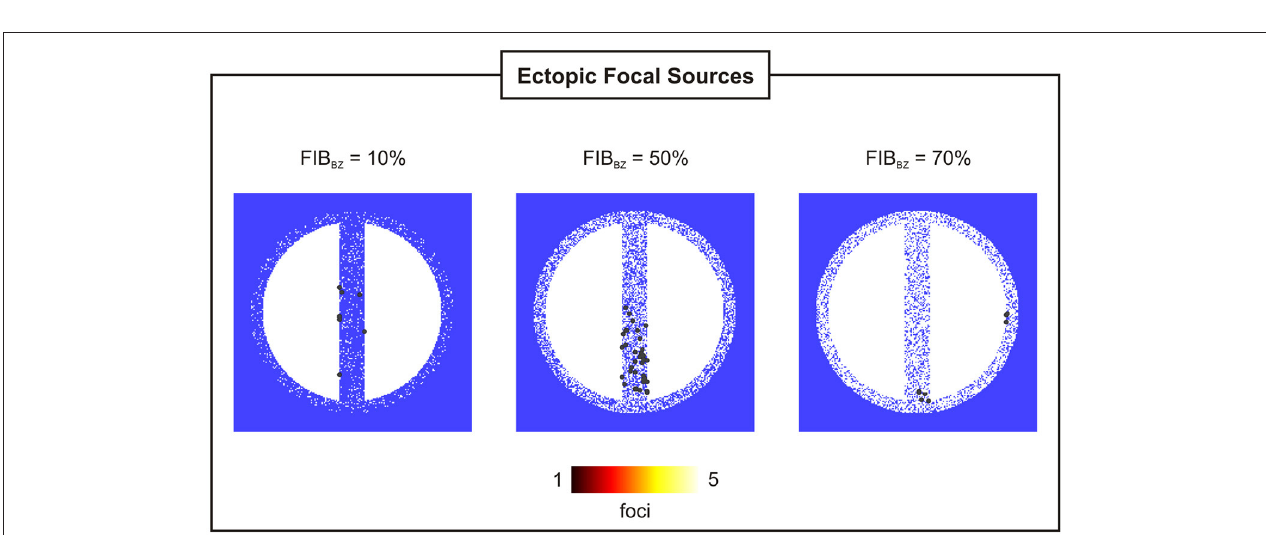
FIGURE 8 | Statistics of PVCs in 2D sheets with different FIB BZ . (A) Probability p PVC of SCR-mediated PVCs. (B) Average waiting time t PVC .